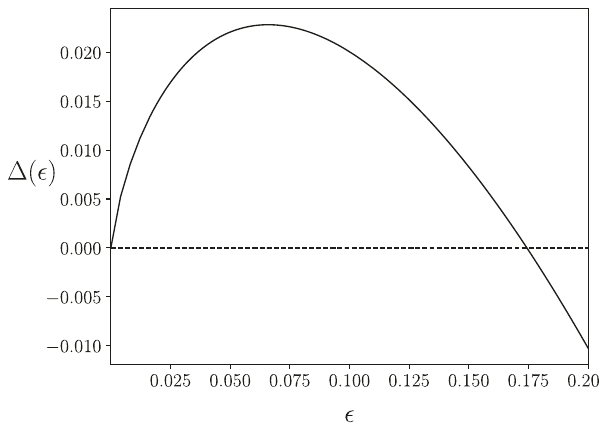
Fig. 3 Illustration of log-singularity-based mechanism behind positivity of the channel coherent information. For the channel B de fi ned by isometry in eq. 4, the entropy difference Δ ( ϵ ) = S b ( ϵ ) − S c ( ϵ ) for density operators below eq. 4 as a function of ϵ is plotted above. Here S b ( ϵ ) and S c ( ϵ ) have the same entropy at ϵ = 0 and they both have ϵ log -singularities. The singularity in S b ( ϵ ) has a rate x b = 9/13 which is higher than x c = 6/13, the rate of the singularity in S c ( ϵ ). This higher rate x b makes both Δ ( ϵ ) and Q ð 1 Þ ð B Þ strictly positive for small ϵ , even though for larger ϵ , Δ ( ϵ ) < 0.